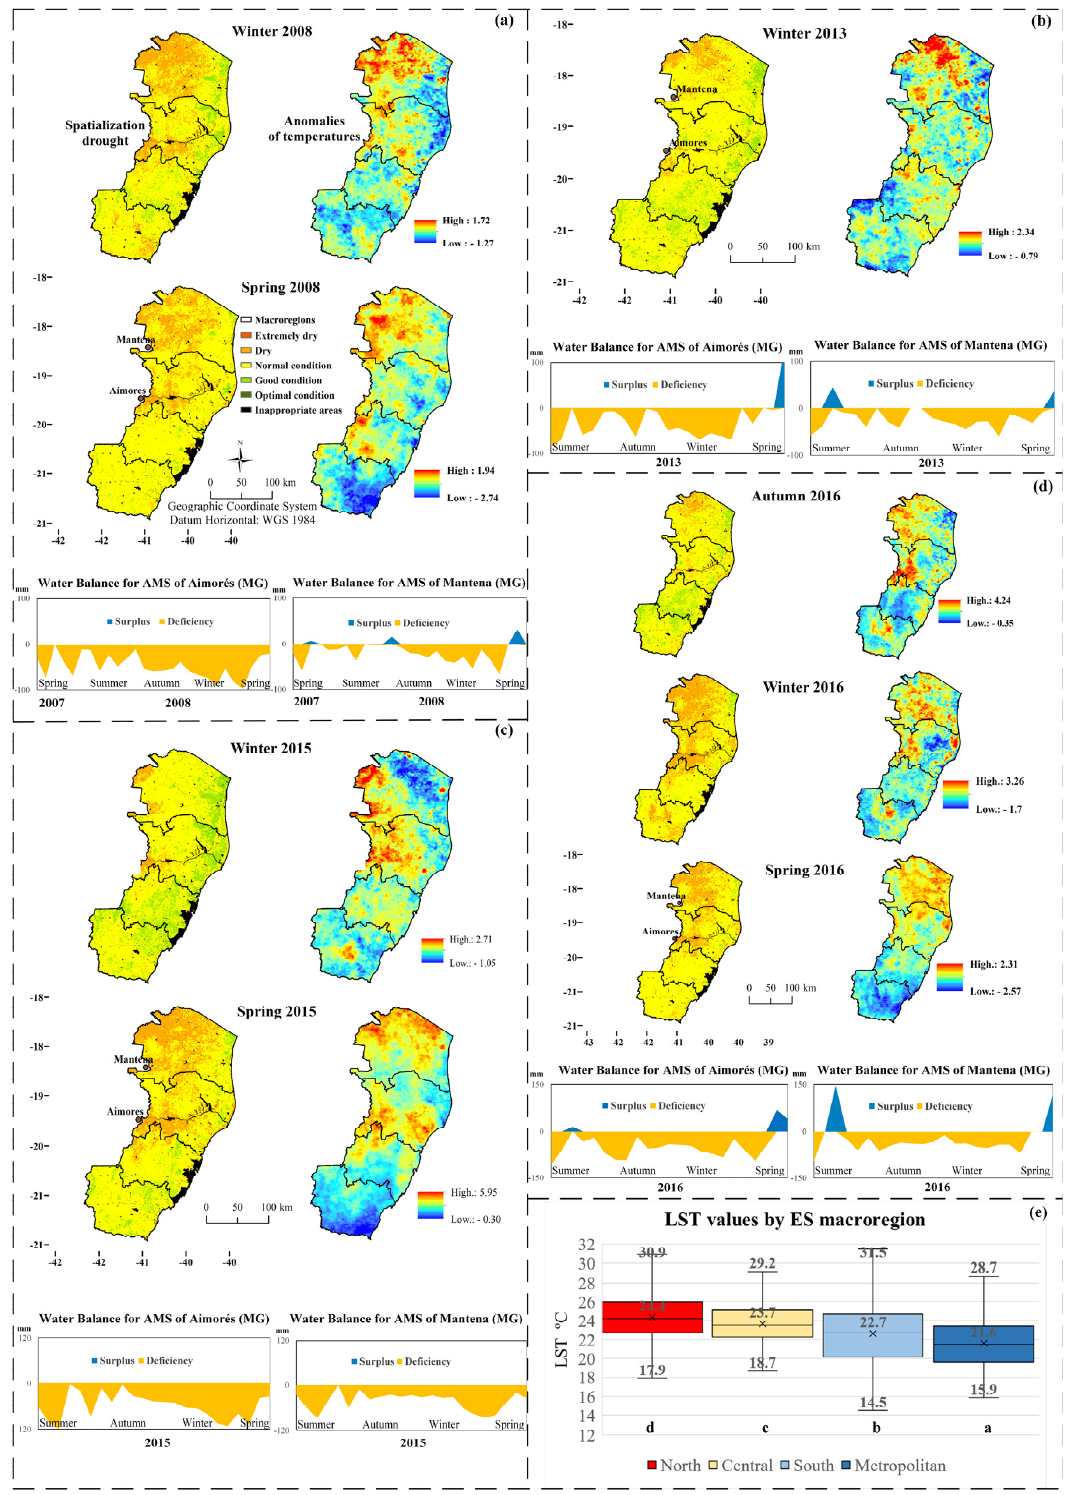
Figure 6. Spatialization of the droughts and LST anomalies in Espírito Santo with the respective water balance of two AMS located in the most vulnerable areas for winter and spring in 2008 ( a ); winter in 2013 ( b ); winter and spring in 2015 ( c ); fall, winter, and spring in 2016 ( d ). Comparison of the average LST values by Esp í rito Santo’s planning macroregions from 2008 to 2017 ( e